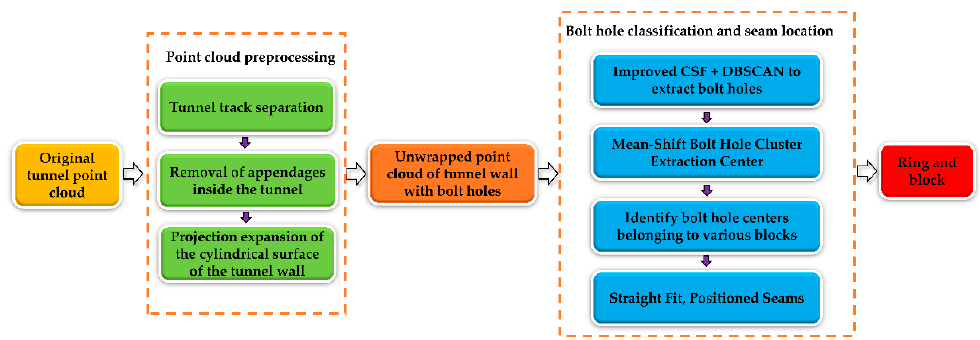
Figure 1. Flowchart of bolt hole extraction and seam location of shield tunnel.